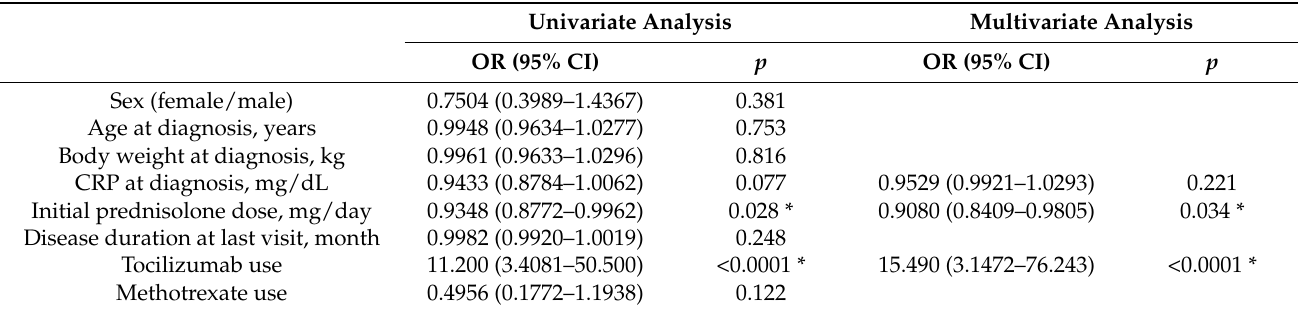
Table 3. Univariate and multivariate logistic regression analyses of factors for discontinuation of prednisolone at the last